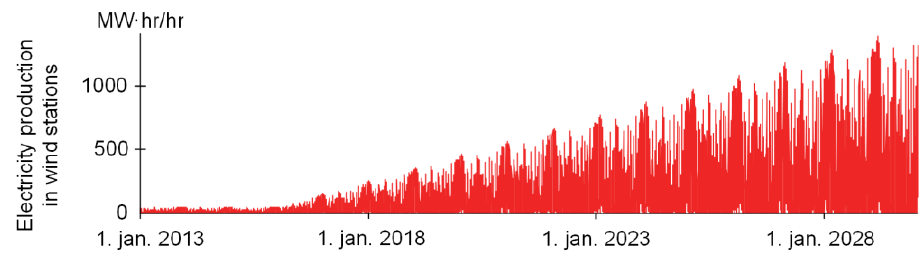
Fig. 4. Electricity generated by wind power